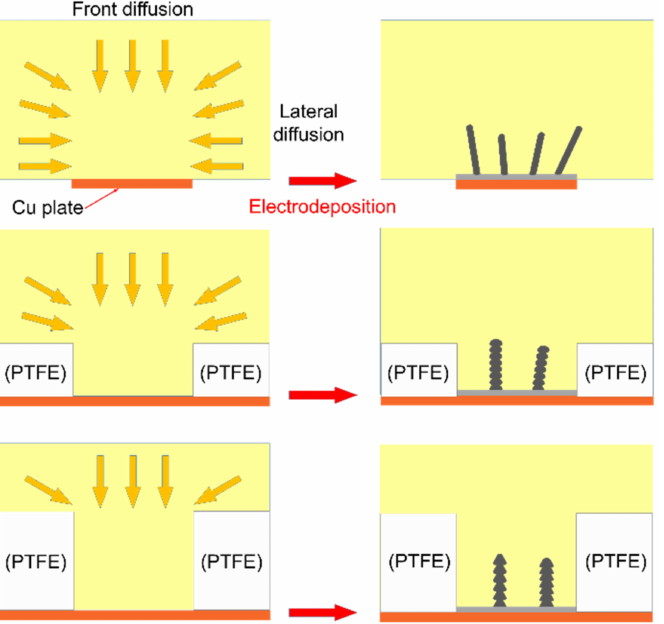
Figure 3. Schematic of the diffusion and morphology differences between the unrestricted diffusion condition and the restricted diffusion